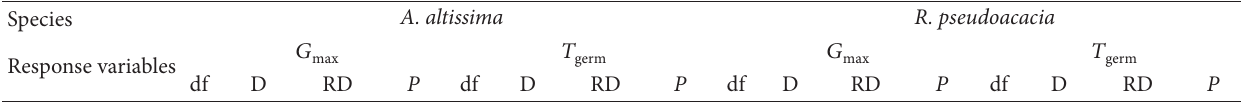
Table 3: Generalized linear models assessing the importance of seed age, seed bank type, and population on cumulative seed germination ) and mean time to germinate ( 𝑇 ) in A. altissima and R. pseudoacacia in the 2011-2012 experiment. ( 𝐺 max germ Species